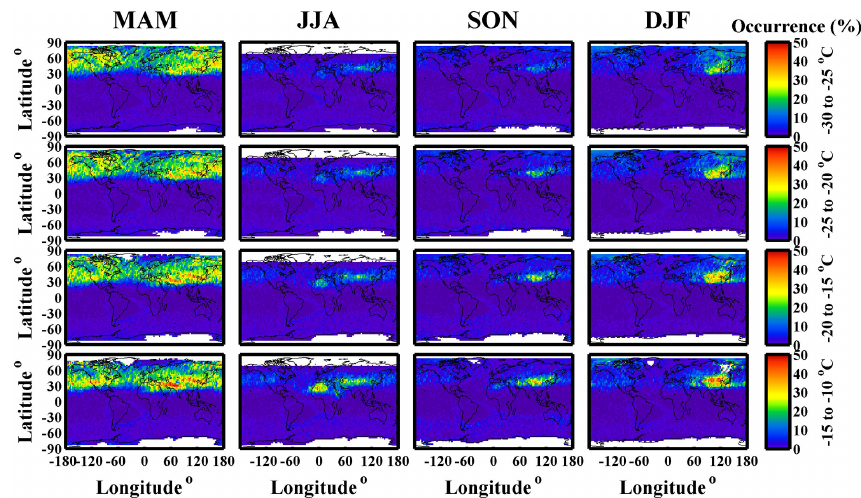
Figure 8. Distributions of global dust occurrences and their seasonal variations at different sub-freezing temperature ranges based on the dust dataset developed by Luo et al. (2015). Temperature ranges are given at the right. Each column is for a season, with the abbreviations described in Fig.